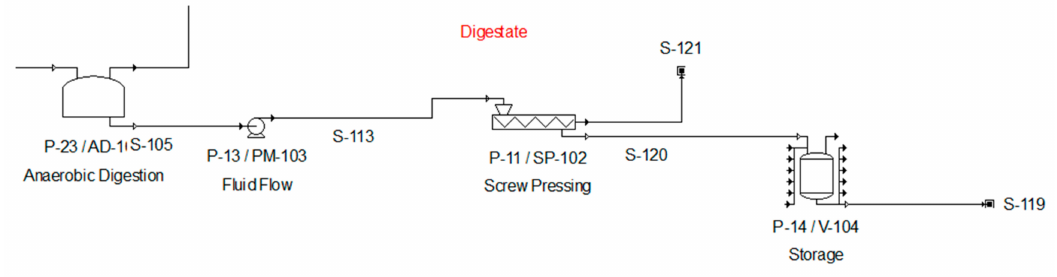
Figure 4. Process flow diagram of the digestate processing in SuperPRO Designer.